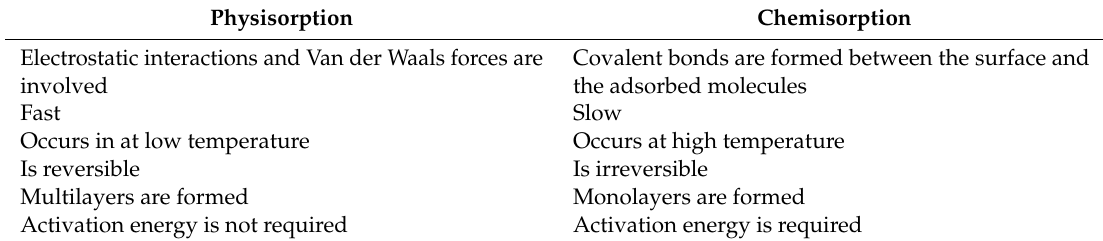
Table 2. Differences between physisorption and chemisorption.